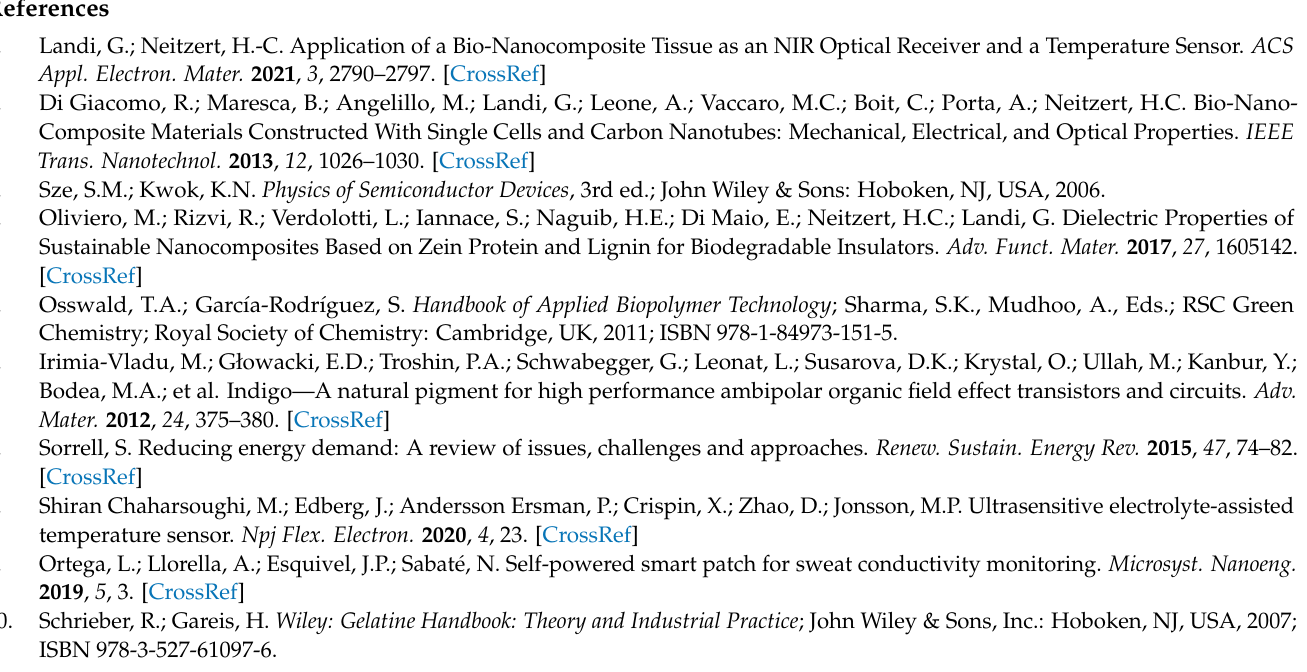
Table S1: Device performances as a function of the bias current at 260 K; Table S2: Device performances as a function of the bias current at 270 K; Table S3: Device performances as a function of the bias current at 280 K; Table S4: Device performances as a function of the bias current at 290 K; Table S5: Device performances as a function of the bias current at 300 K; Table S6: Device performances as a function of the bias current at 310 K; Table S7: Device sensitivity as a function of the bias current; Table S8: Energy consumption as a function of the